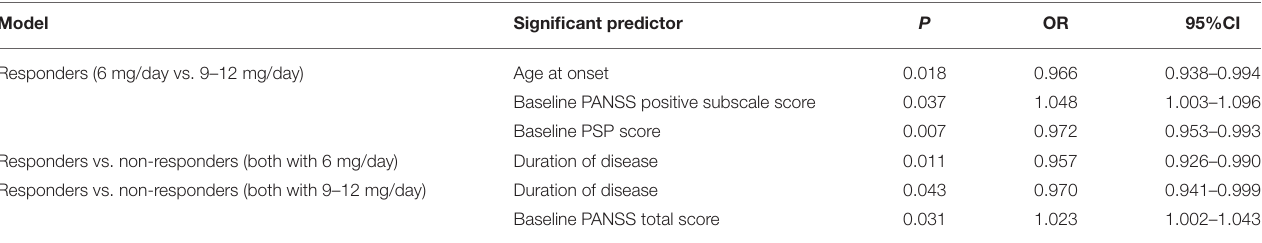
TABLE 3 | Baseline predictors identified using exploratory analyses with explanatory variables entered into the multivariable stepwise logistic regression model.